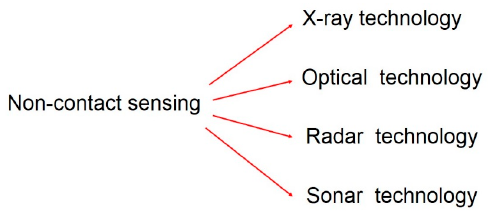
Figure 18. Non-contact sensing technology map.